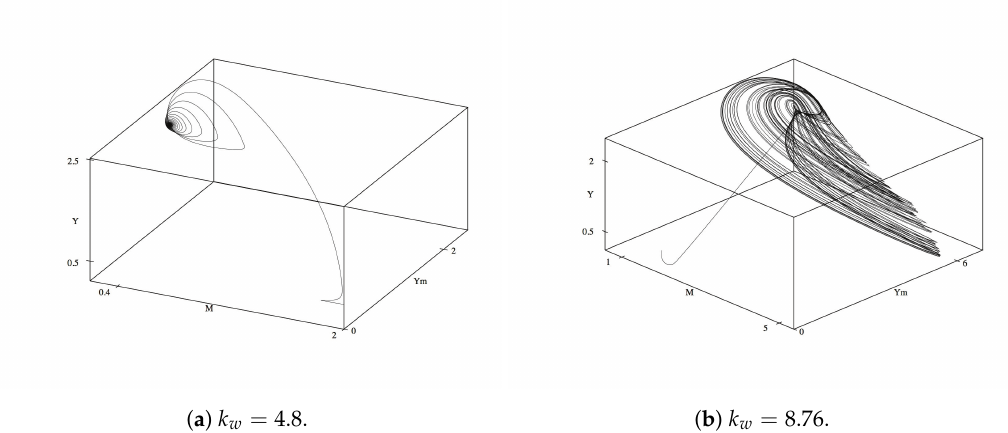
Figure 2. Phase plane diagrams for ( M , Y m , Y ) for varying k w and same parameters as in Figure 1.